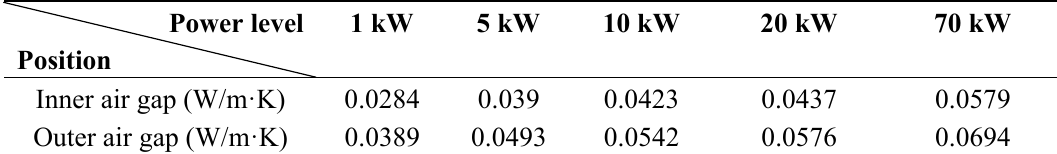
Table 6. Thermal coefficient of air gap.